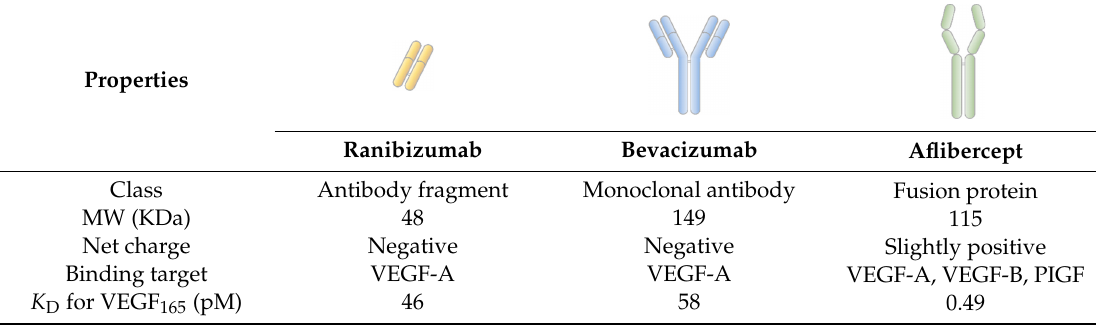
Table 1. Properties of anti-vascular endothelial growth factor (VEGF) antibodies for Age-Related Macular Degeneration (AMD). Data from [23–25].